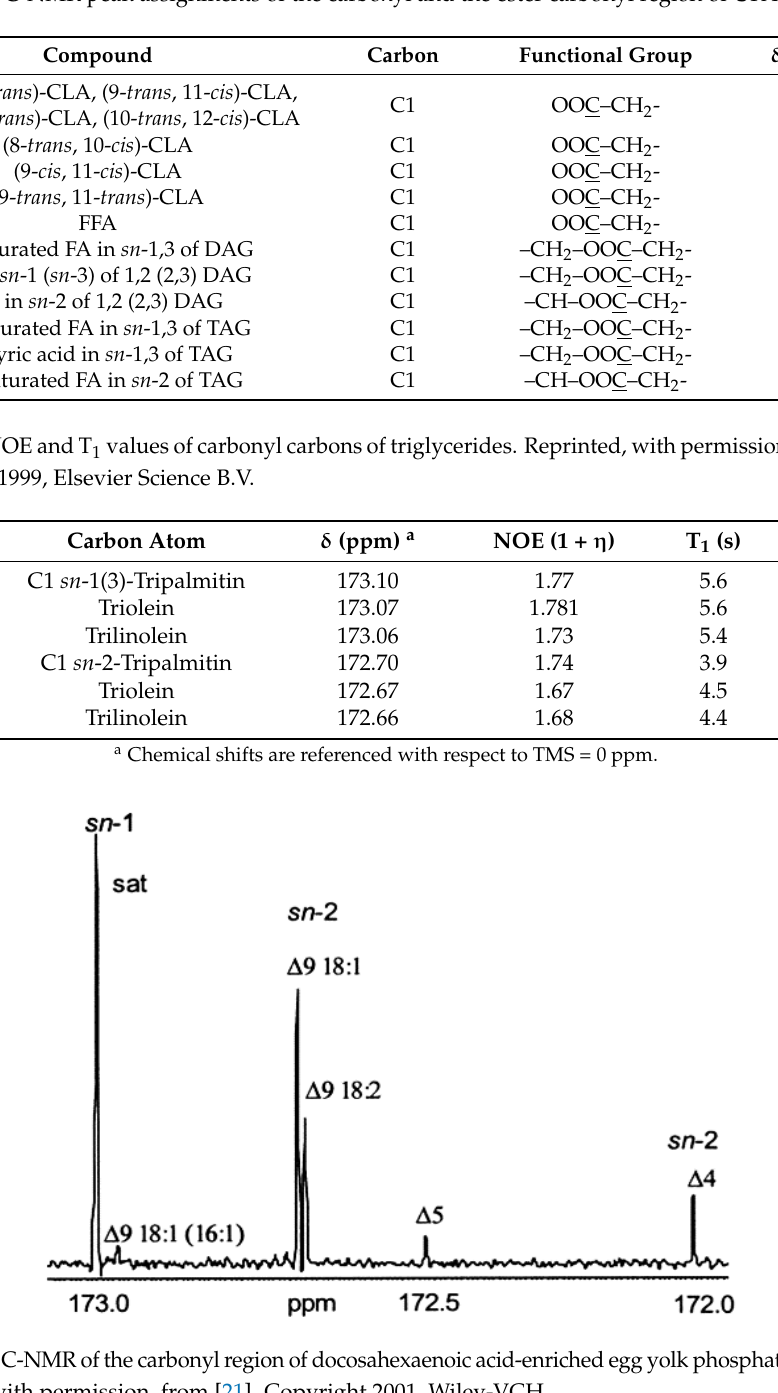
Table 12. NOE and T 1 values of carbonyl carbons of triglycerides. Reprinted, with permission, from Table 11. 13 C-NMR peak assignments of the carboxyl and the ester carbonyl region of UFAs in CDCl 3 .